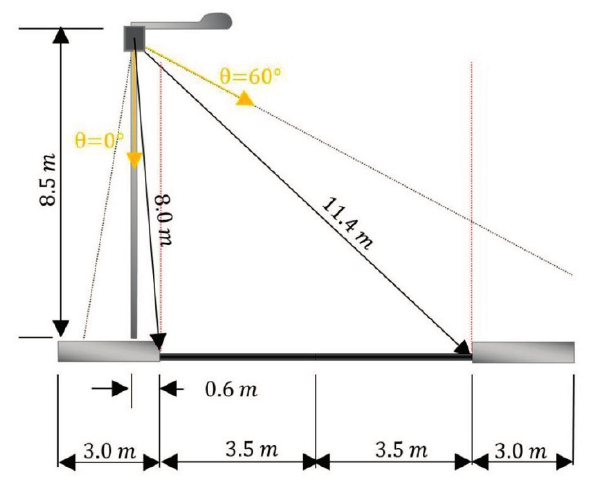
Figure 19. UIS Laser node